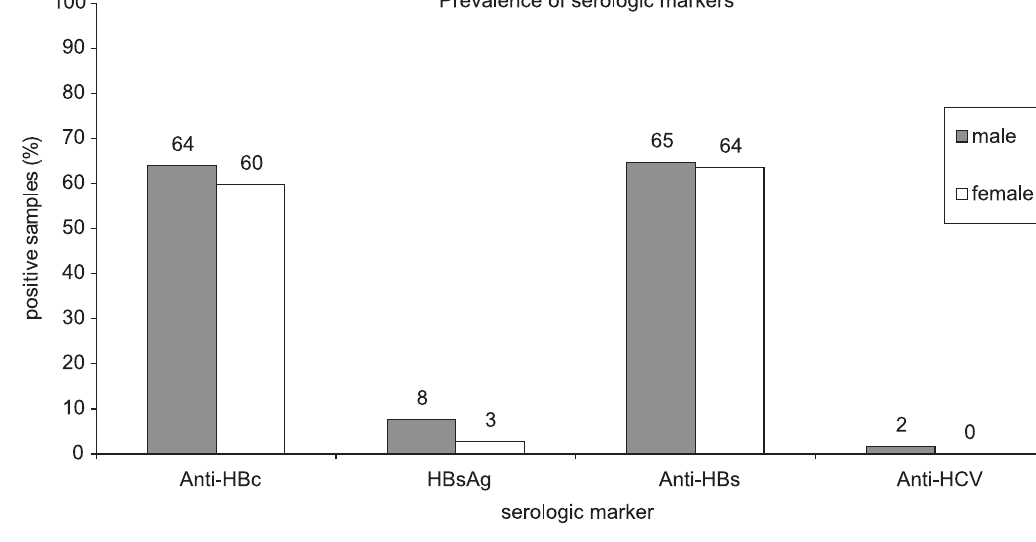
Figure 2 - Positive serologic markers by